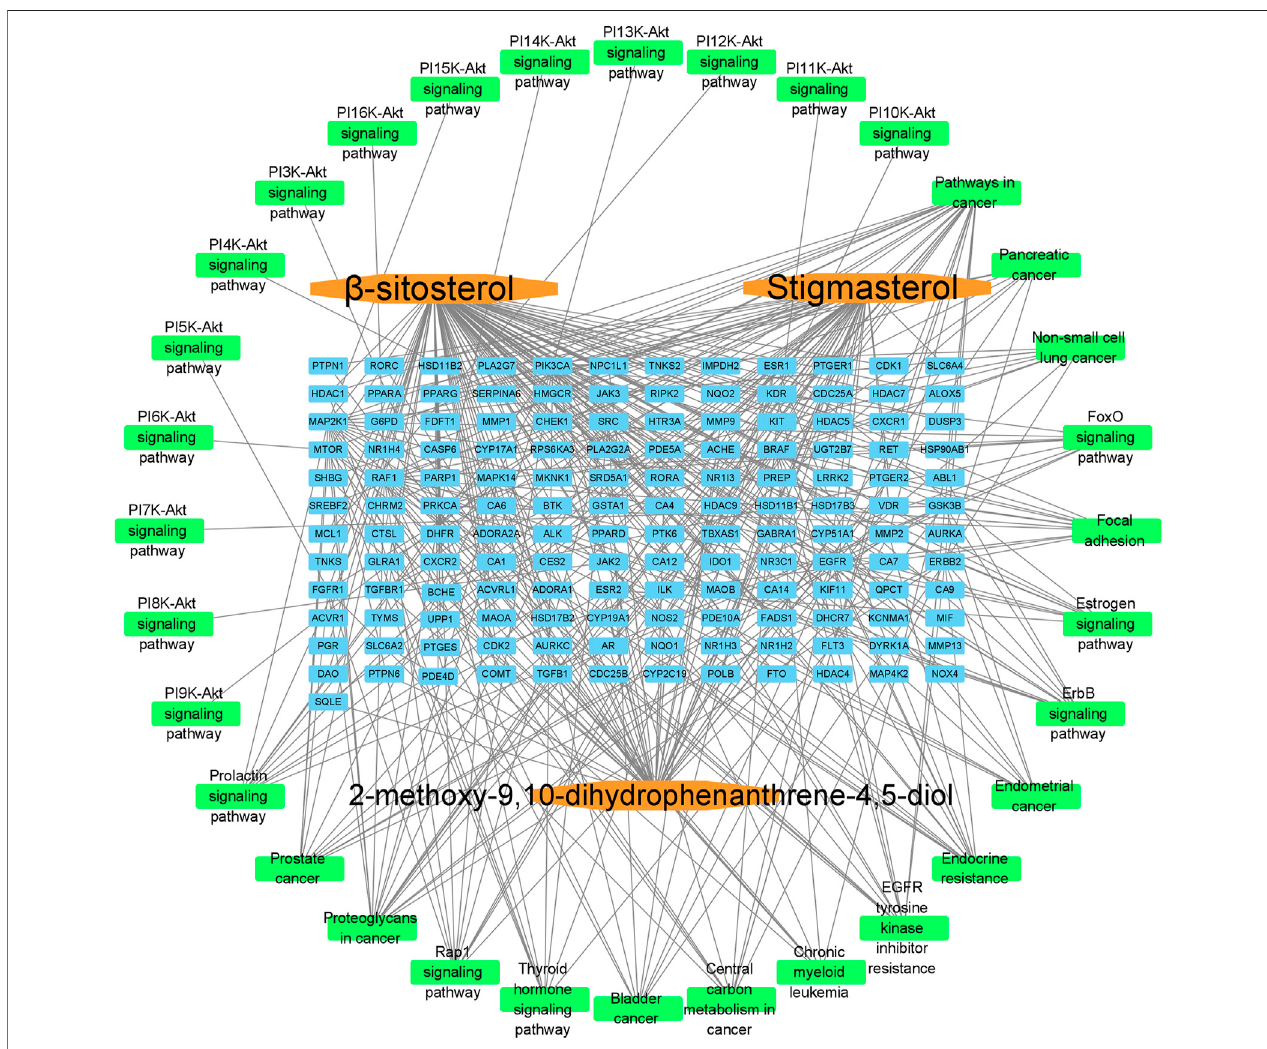
FIGURE 5 | Component-target-signal pathway. The orange boxes indicate the active ingredients. The blue boxes indicate the gene names. The green boxes indicate the signal pathways.